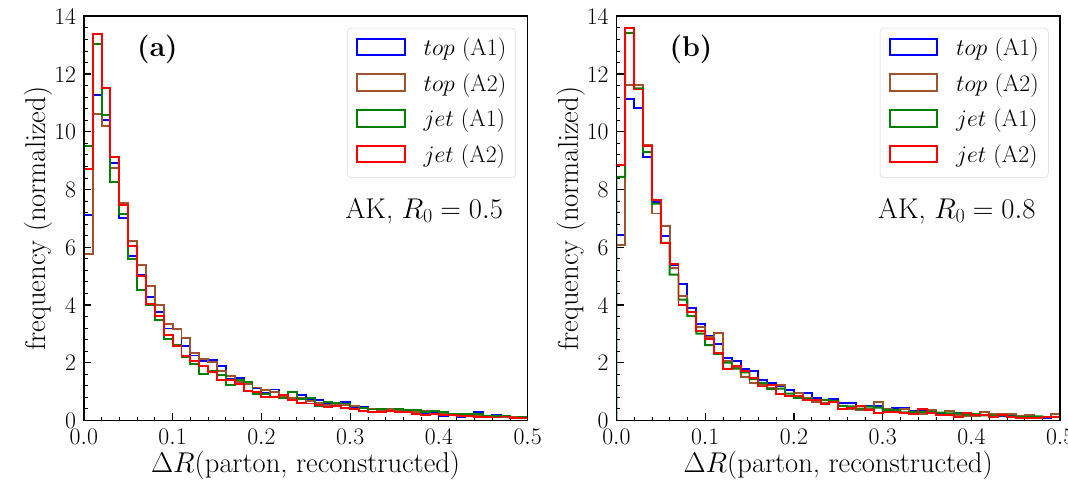
Figure 2 . Normalized distribution of ∆ R between the MG5 parton-level object and corresponding reconstructed jet. The jets were clustered using the AK algorithm with radius parameters (a) 0.5 and (b) 0.8.